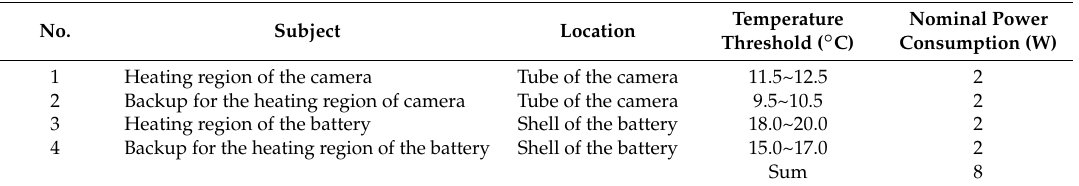
Table 11. Parameters of the heating regions of the Luojia 1-01 satellite.